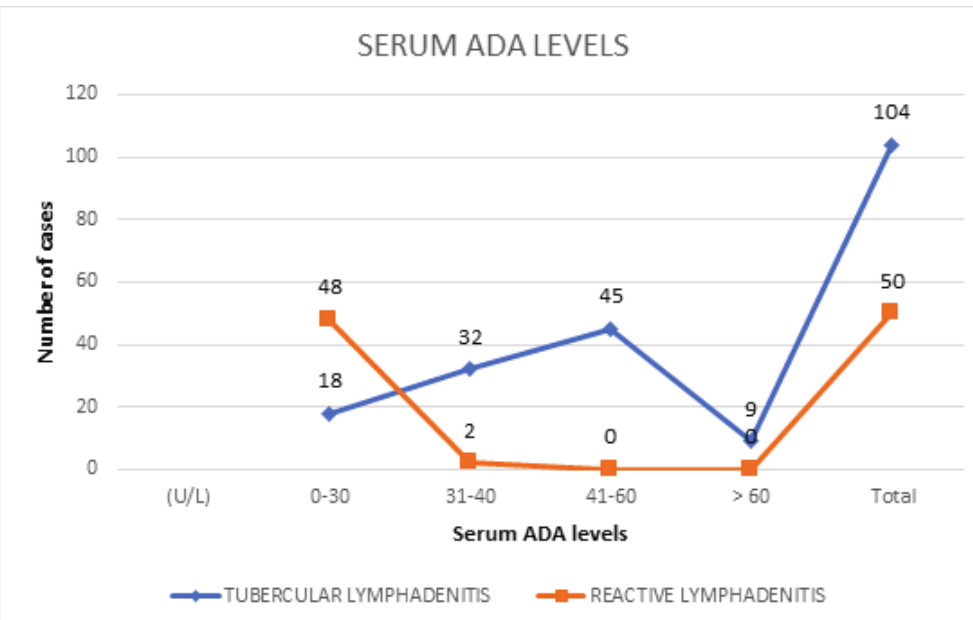
Figure 5 : Comparison of serum ADA levels between cases of tubercular and reactive lymphadenitis (Department of Pathology, TMU, January 2019 to June 2020) n =